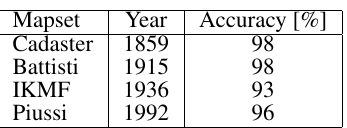
Table 5. Accuracy of the classification of the forest coverage class for the different historical